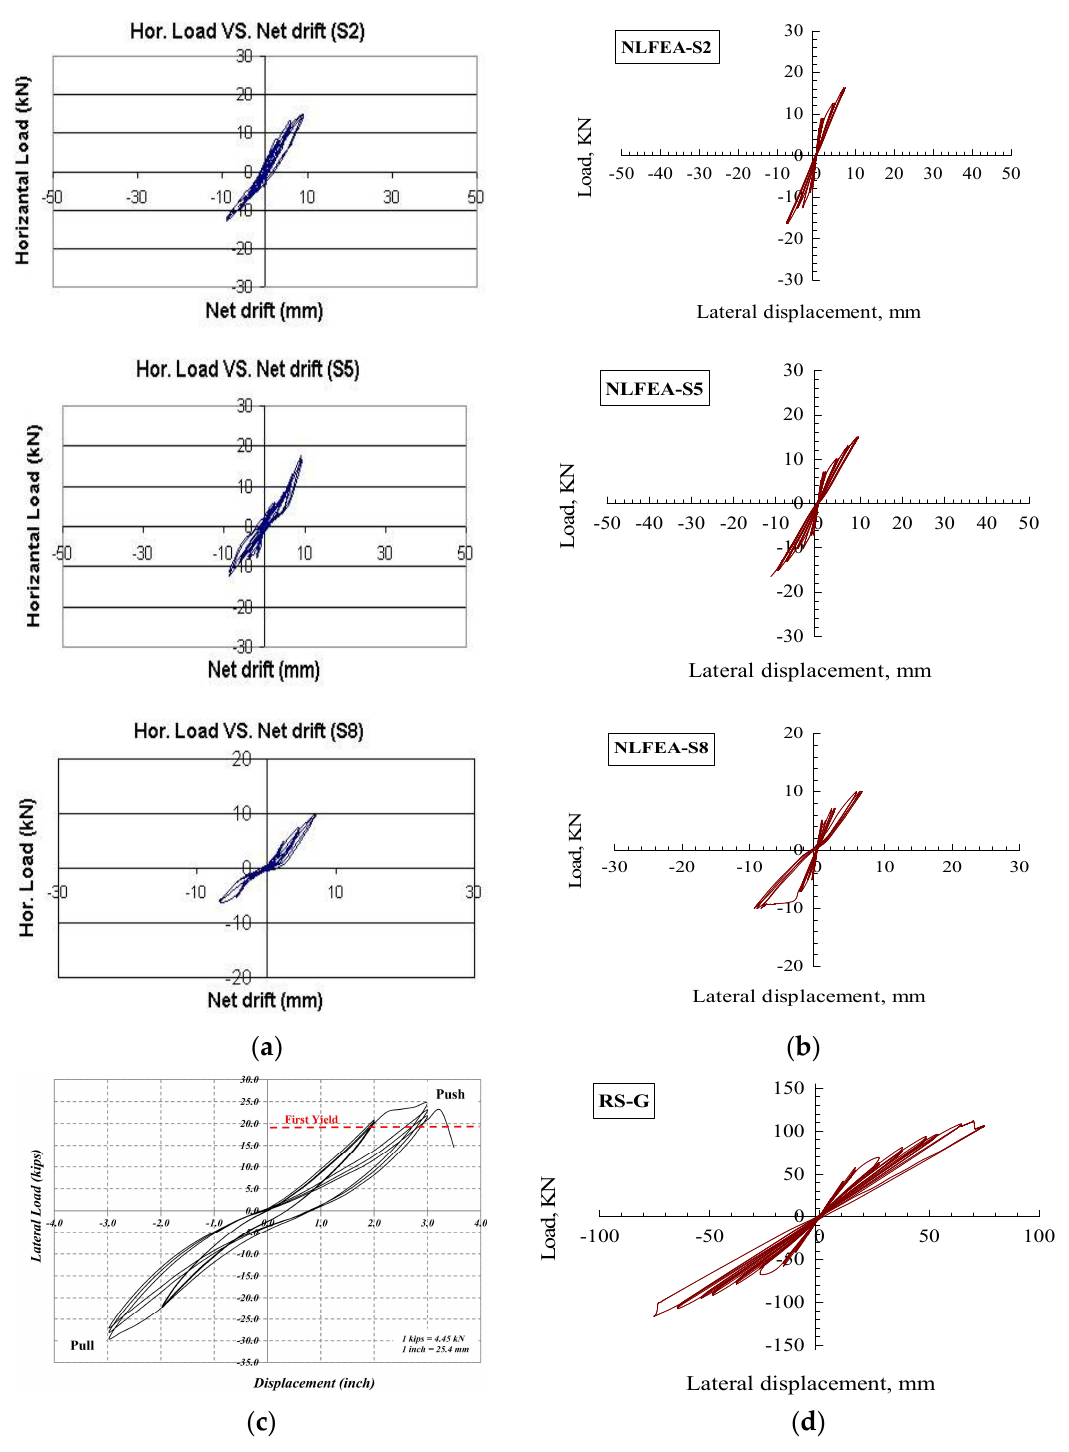
Figure 4. The hysteretic loops validation. ( a ) Shannag and Alhassan [33] control B-C, ( b ) NLFEA control B-C, ( c ) Khaled et al. [57] strengthened B-C, ( d ) NLFEA strengthened